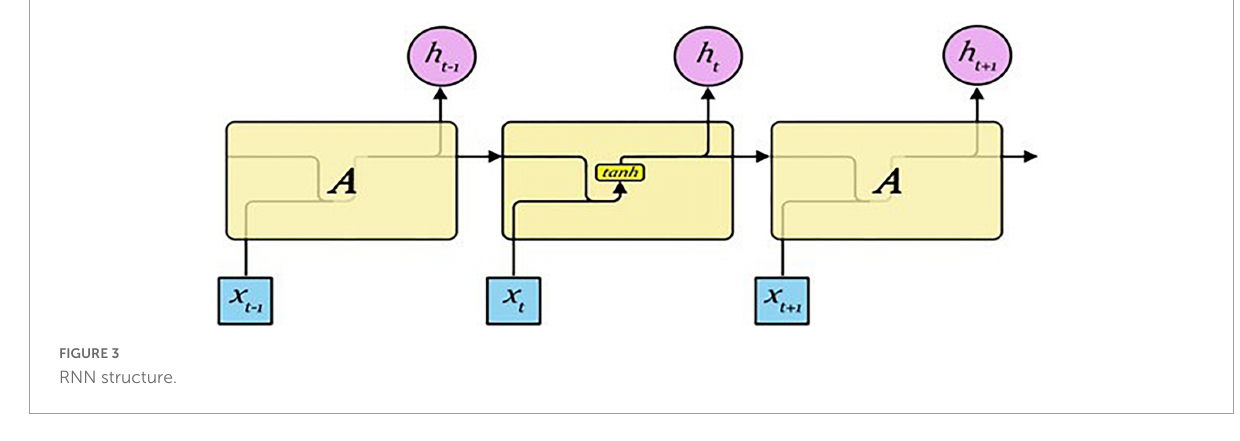
FIGURE3 RNN structure.